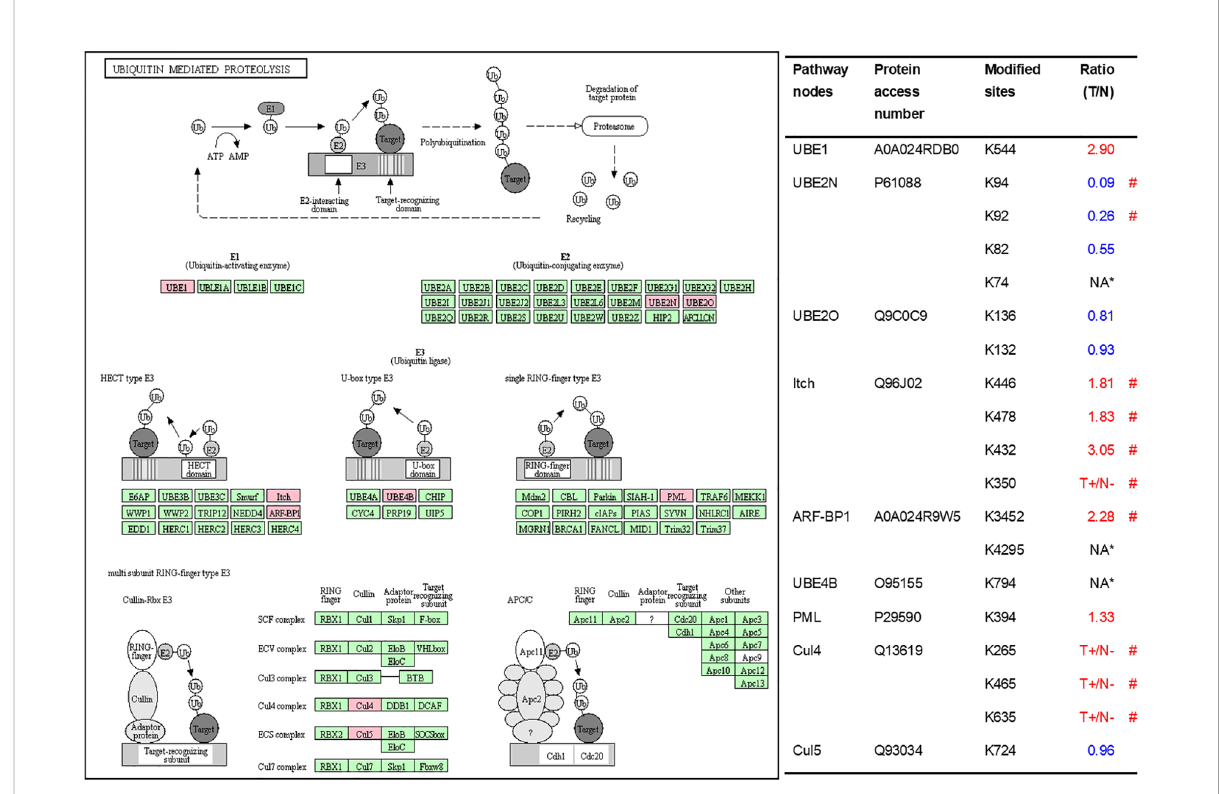
FIGURE 9 Ubiquitination-mediated UPS-related enzymes. Pink = the identi fi ed ubiquitinated subunits. Green = non-ubiquitinated subunits. K* = ubiquitinated lysine residue. Red indicates the degree of ubiquitination of this site is upregulated, and blue indicates downregulated. Ratio(T/N) = Ratio of tumor to control. T+/N- = ubiquitination only in tumor. NA* means no quantitative information in both tumor and control. # means statistically signi fi cantly altered ubiquitination level in tumor compared to